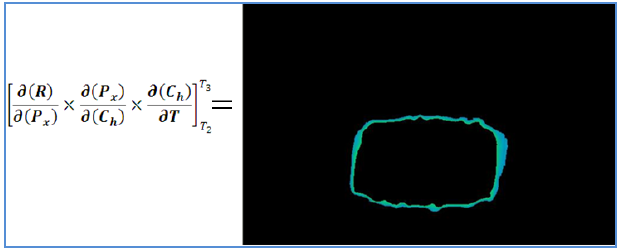
Figure 17. Chromatics value for yellow alarm temperature level with canonical formation